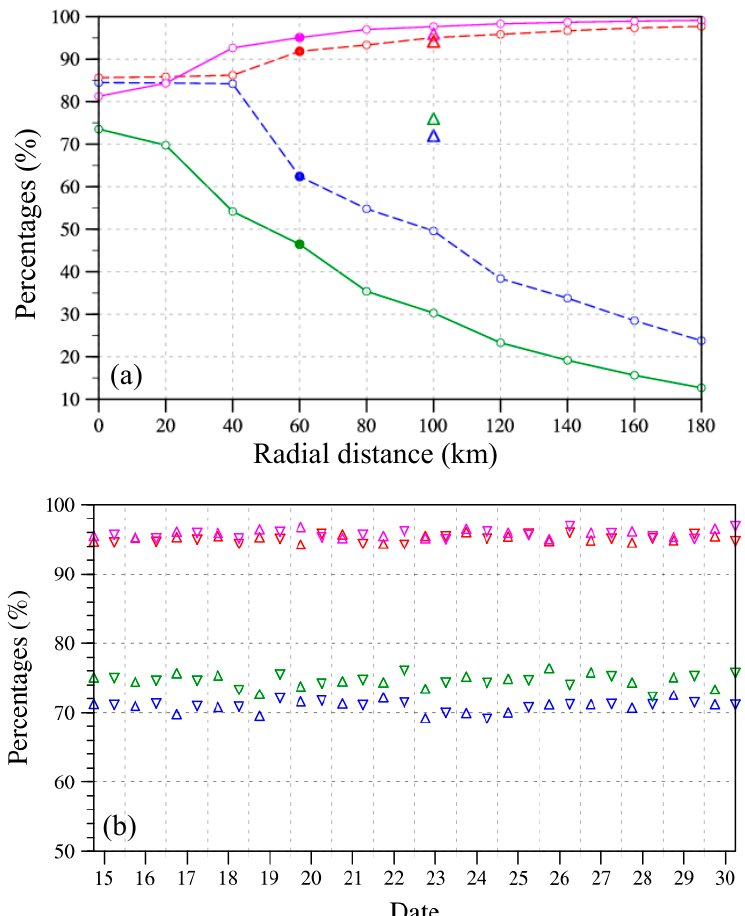
Figure 15. ( a ) Percentages of correctly rejected cloudy data (red for AMSU-A, magenta for MWTS-2) and successfully identified clear-sky data (blue for AMSU-A, green for MWTS-2) as functions of the radius used in the second step to remove all data within that radial distance of cloudy points satisfying ξ > 2K, as well as the final results of the correctly identified clear-sky and cloudy data by the N18 O − B (solid dots) and the newly proposed (upward triangles) schemes for all data at ascending nodes over oceans on 15 July 2014. ( b ) Daily variations in percentages of correctly selected clear-sky data (blue for AMSU-A, green for MWTS-2) and rejected cloudy data (red for AMSU-A, magenta for MWTS-2) at ascending (upward triangles) and descending (downward triangles) nodes during 15–30 July 2014.